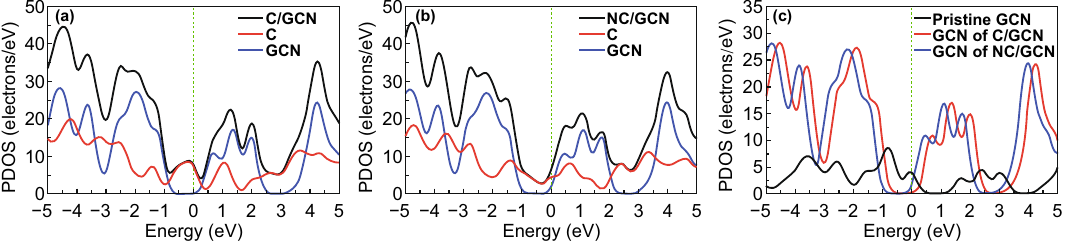
Fig. 8 a The PDOS of C/GCN, b NC/GCN systems, and c GCN in different systems. The vertical dash lines are the position of the Fermi